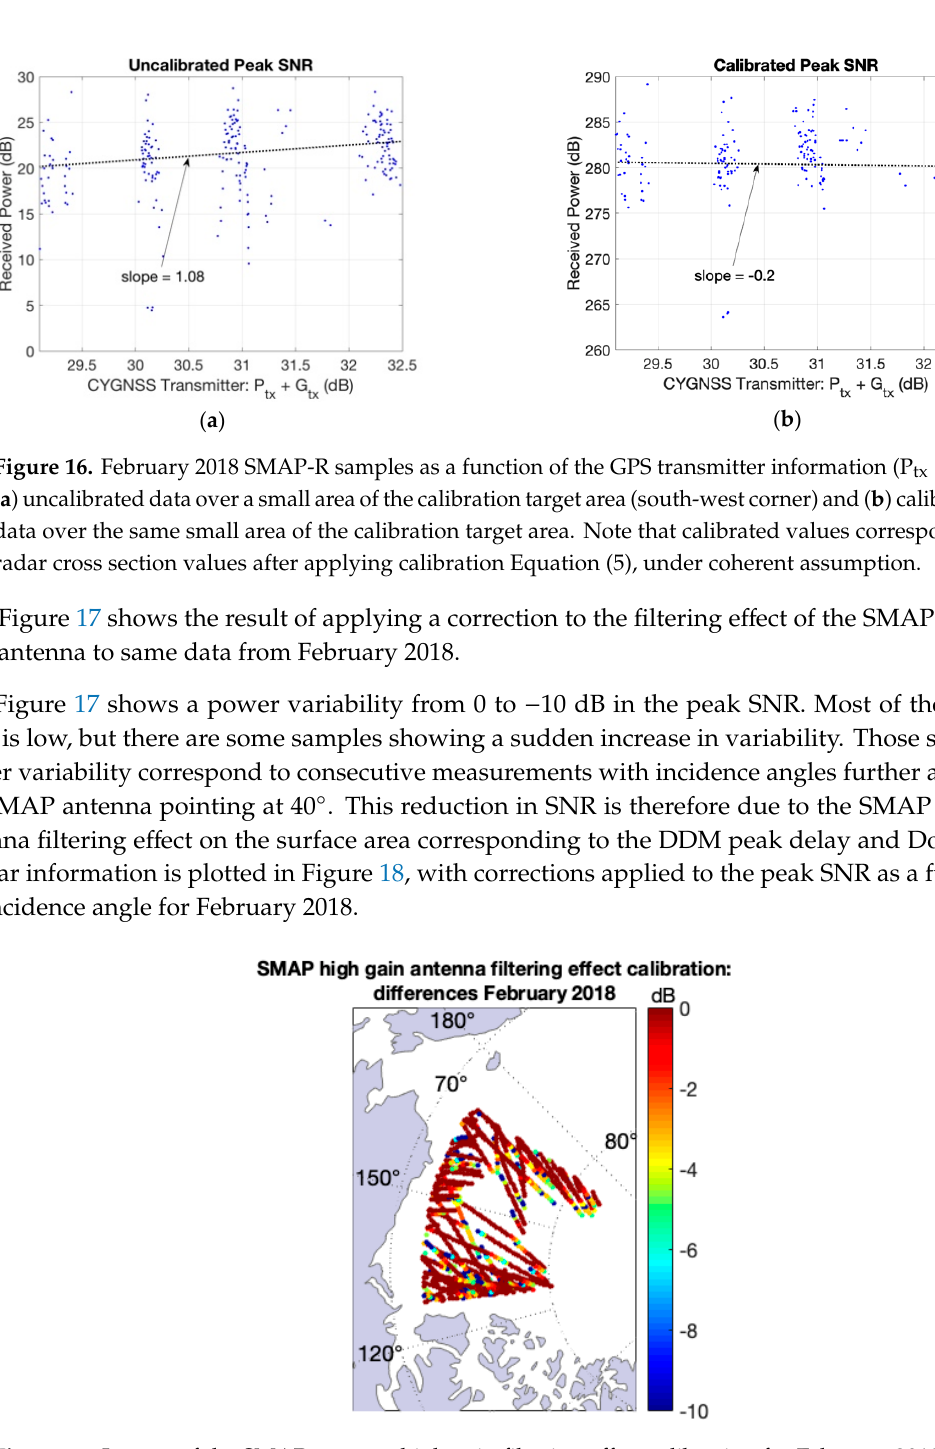
Figure 18. Corrections applied to peak SNR as a function of the incidence angle for February 2018. Corrected peak SNR = peak SNR – ∆𝑣 . Figure 18 shows that the larger corrections correspond to reflections farther away from the SMAP antenna boresight. When considering only the delay–Doppler bin of the DDM peak, no correction is needed for incidence angles close to the antenna boresight (40°). For reflections with incidence angles below 38.4° and over 41.6° incidence angle, relevant corrections are needed. The